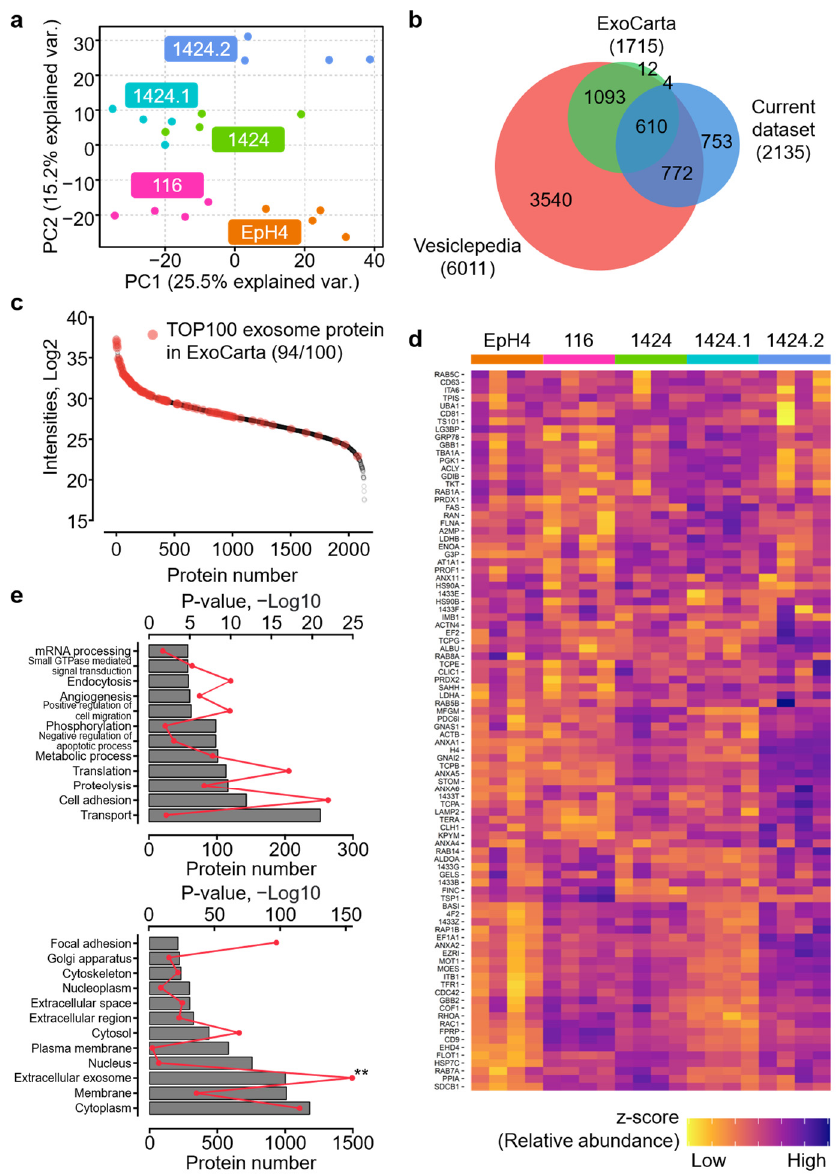
Figure 2. Proteomics characterization of the isolated exosomes. ( a ) Principal component analysis (PCA) of the proteomic profiles of the five cell lines; ( b ) Venn diagram showing the overlap between the proteins quantified in the current dataset and those archived in two extracellular vesicle databases, Vesiclepedia and ExoCarta; ( c ) ranked MS intensities of the quantified proteins. Red dots denote TOP100 exosome proteins in theExoCarta database; ( d ) normalized abundance of the 94 ExoCarta TOP100 exosome proteins quantified in this dataset; ( e ) gene ontology (GO) biological process (BP) and cellular component (CC) terms enriched from the exosome proteome. ** p -value = 0 for the extracellular exosome GO CC